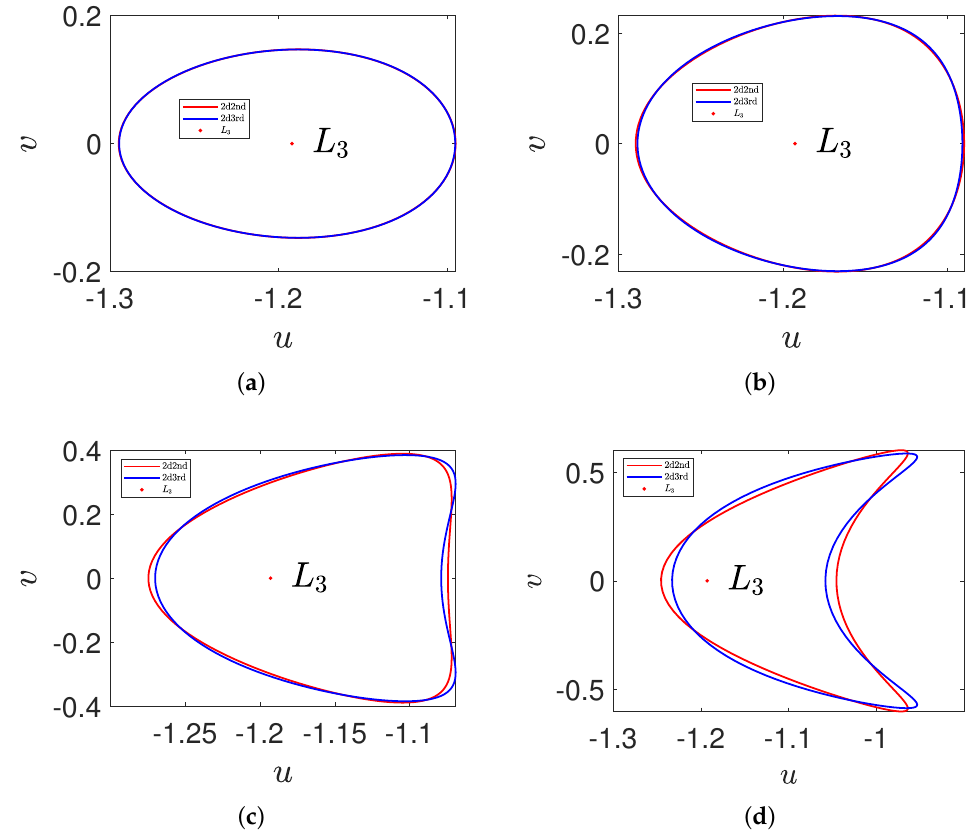
Figure 9. The approximate periodic solutions in two-dimensional plane for ( a ) κ = 0.5, ( b ) κ = 1, ( c ) κ = 2, and ( d ) κ = 4,